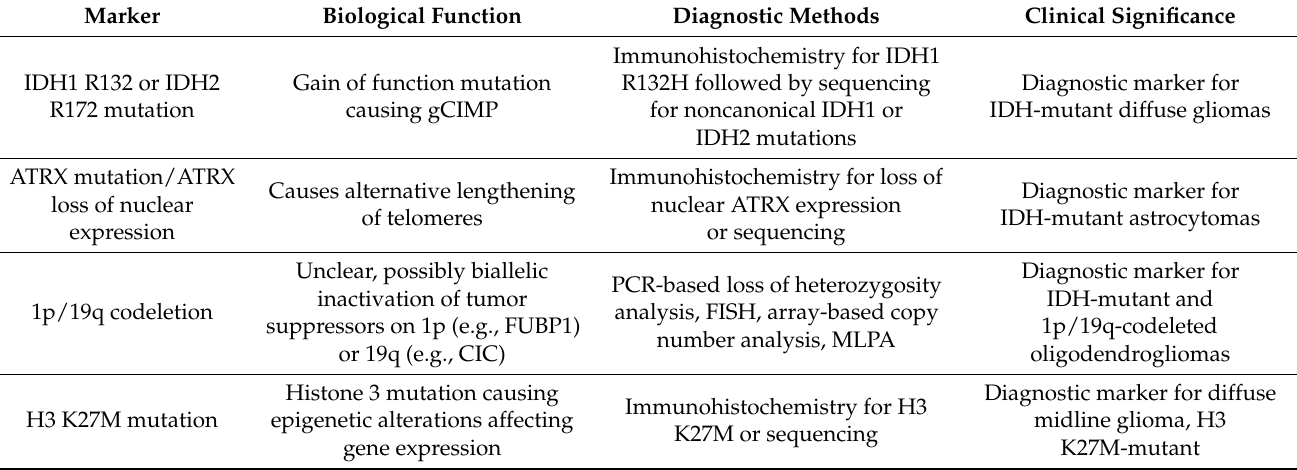
Table 2. Molecular marker in diffuse